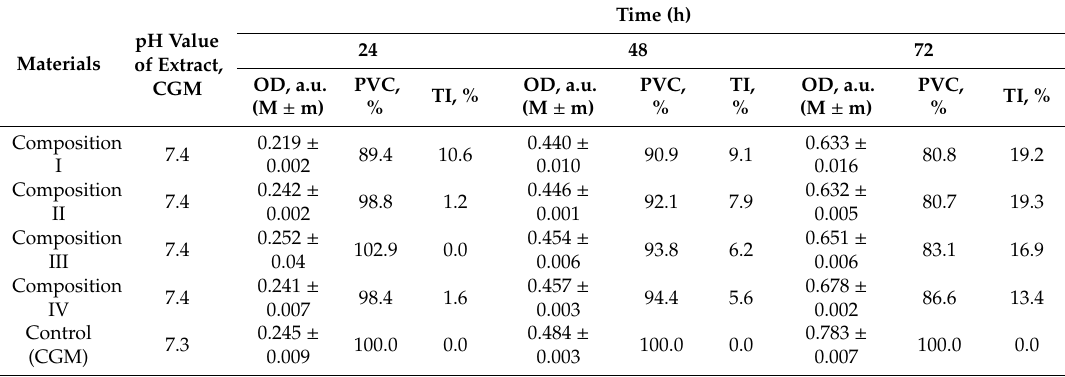
Table 2. The results of in vitro investigations: the pH of the extracts, the values of the optical density (OD) of the formazan solution (MTT test), the pool of viable cells (PVC) and the toxicity index (TI) during the cultivation of human sarcoma cells of the MG-63 cell line in the presence of the extracts of samples based on the composite ceramic materials of 3Y-TZP-Al 2 O 3